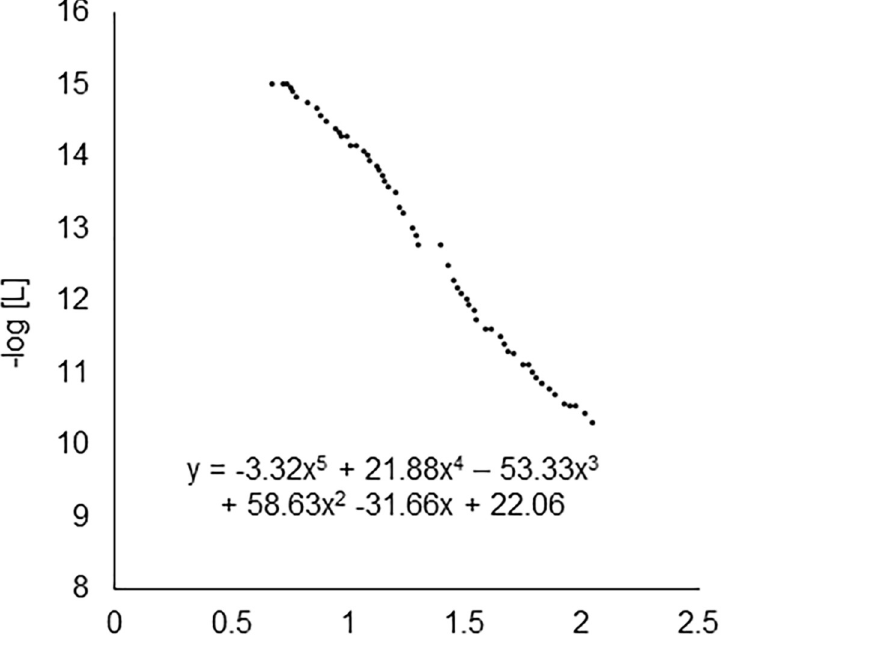
Fig 3. The formation curve of oosporein-Al complex. [L] is the concentration of oosporein that could not chelate Al. The formula shown is that for the approximate curve.